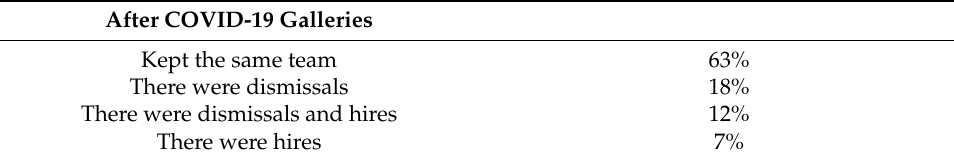
Table 2. Galleries’ employees after COVID-19. After COVID-19 Galleries Kept the same team 63% There were dismissals